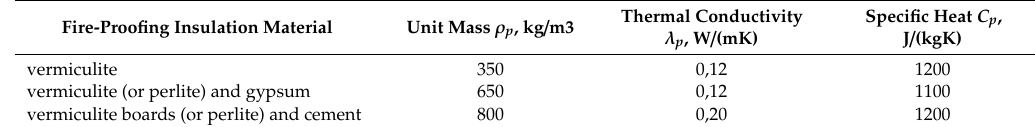
Table 3. Thermal properties of selected fire-proofing materials